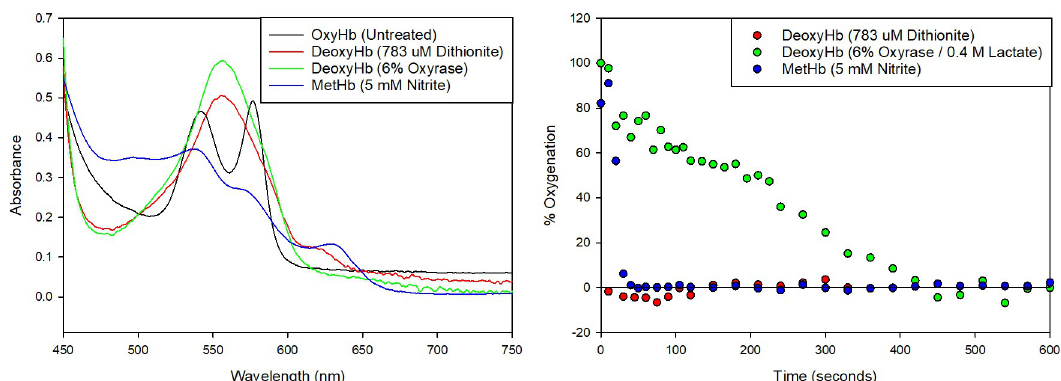
Fig 1. A. Spectra of oxyhemoglobin, deoxyhemoglobin and methemoglobin. The spectra of Hb is compared between an untreated, oxygenated sample (black) deoxygenated with 0.78 mM dithionite (red) with a secondary shoulder around 630 nm, suggesting metHb is also present. 6% Oxyrase and 0.4 M lactate (green) curve shows pure deoxyHb and the 5 mM nitrite (blue) curve shows pure metHb. B. OxyHb consumption over time between three Hb reactions. Free oxyHb is treated with 0.78 mM dithionite (red), 6% Oxyrase and 0.4 M lactate (green) and 5 mM nitrite (blue). The percentage of oxyHb is calculated over time using the Tsao method for deoxyHb (dithionite and Oxyrase) and the Winterbourn method (nitrite).